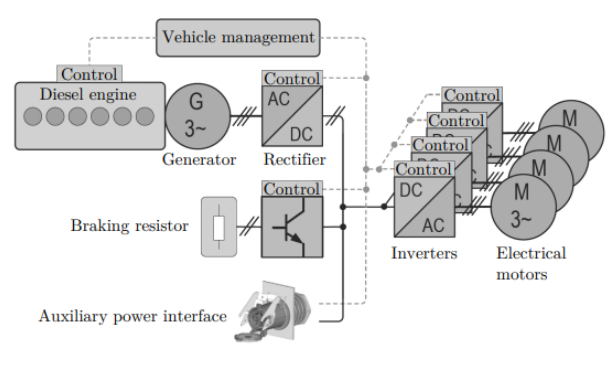
Fig. 10. Rigitrac EWD 120 powertrain architecture [52]